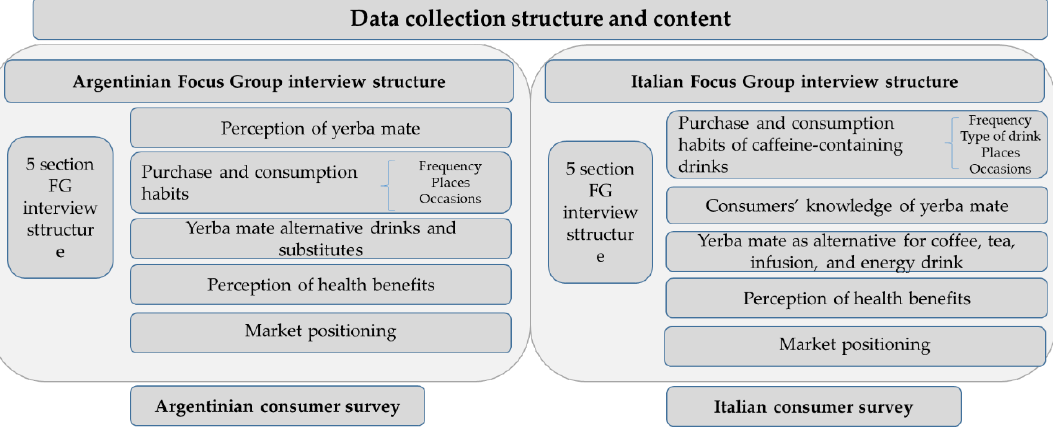
Figure 6. FG data collection structure and content.